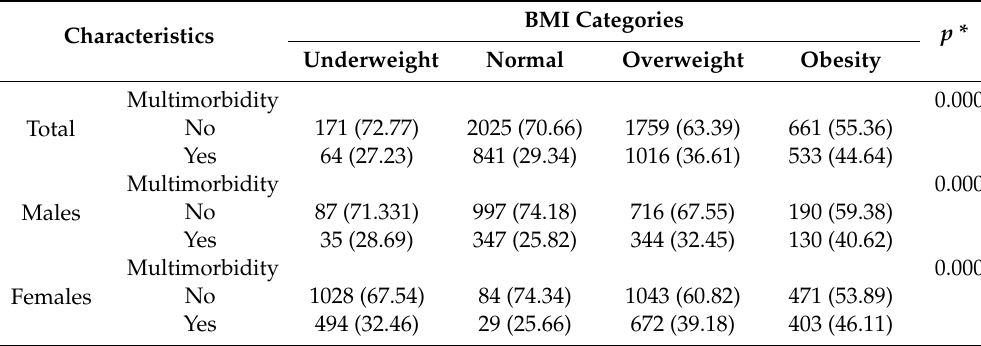
Table 2. Prevalence of multimorbidity (%) by BMI